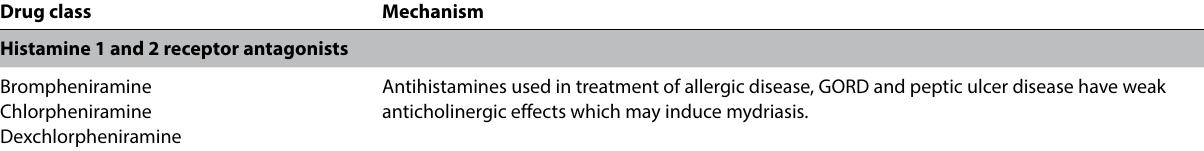
Table 1. Drugs associated with precipitating acute angle closure glaucoma (AACG) Drug